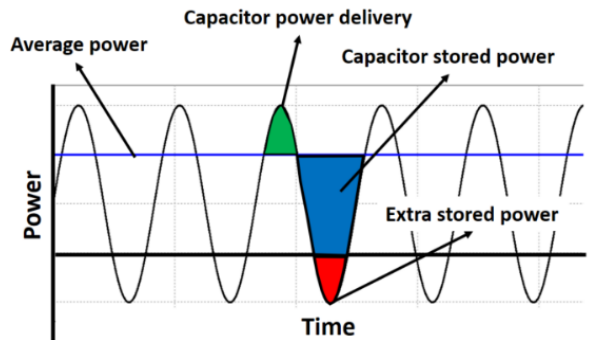
Figure 2. Instantaneous power using the motor as a load.